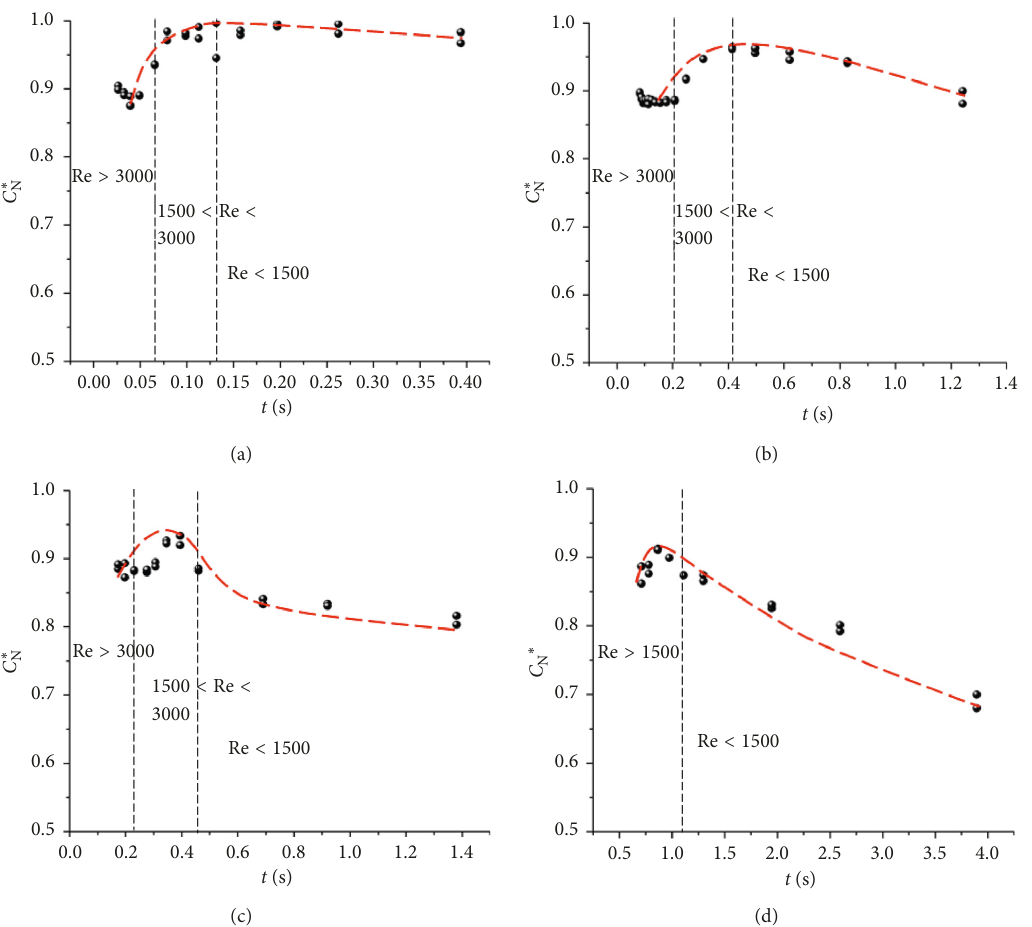
Figure 4: The dimensionless concentration of north outflow C ∗